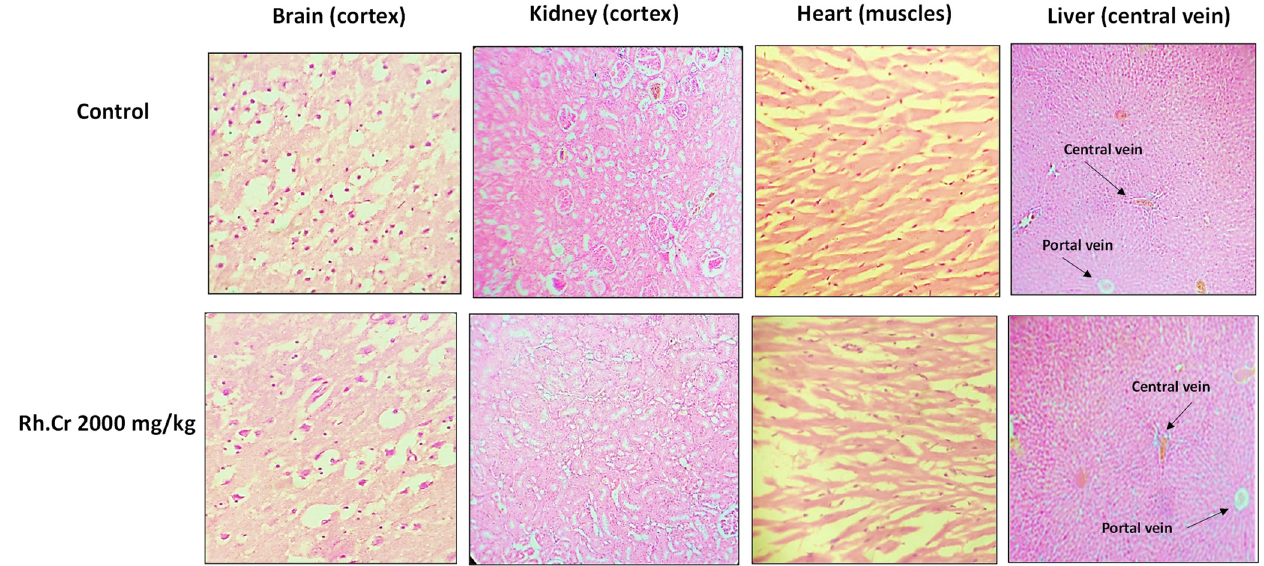
Figure 15. Histopathological slides showing the effect of Rumex hastatus crude extract (Rh.Cr) on vital organs of rats using hematoxylin and eosin staining histopathological technique. Bar 50 µm, magnification 40×.